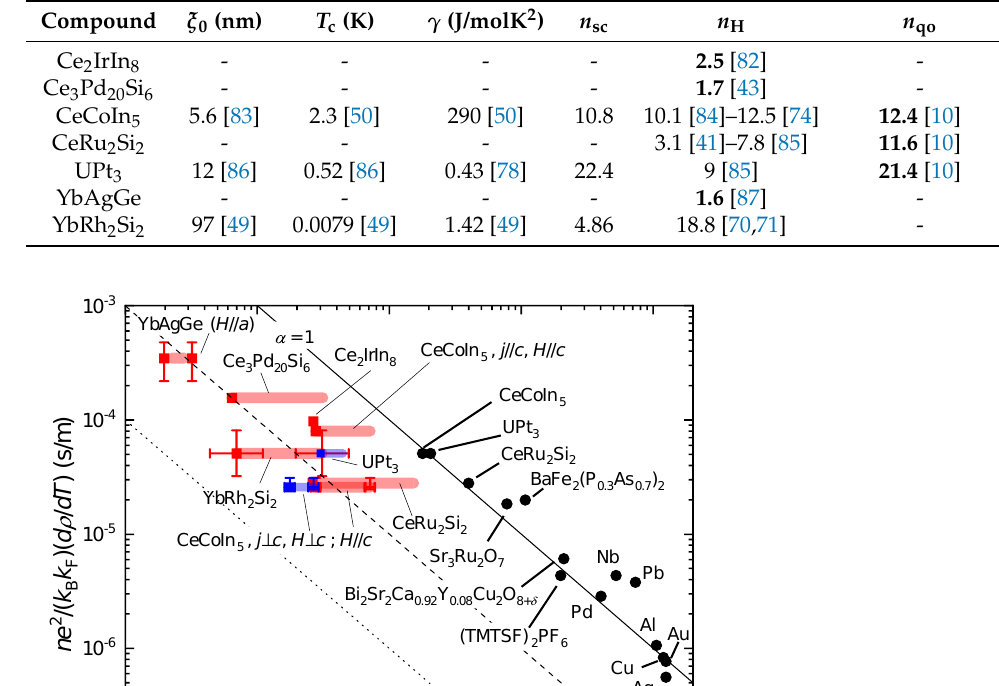
Table 2. Charge carrier concentrations (in nm − 3 ) determined as follows: (i) n sc from the supercon- ducting coherence length ξ 0 , the superconducting transition temperature T c , and the normal-state Sommerfeld coefficient γ , all in zero field, via (20); (ii) n H from the Hall coefficient at the lowest temperatures, where anomalous contributions are minimal, via R H = 1/ ne ; (iii) n qo from quantum oscillation experiments reviewed in [10], by summing up the carrier concentrations from all detected bands. For CeCoIn 5 , the γ coefficient is taken at 2.5 K, without taking into account the logarithmic divergence. The error bar in n used for CeCoIn 5 ( j ⊥ c ) in Figure 3 reflects the range of the parameters given in [74]. YbRh 2 Si 2 is close to being a compensated metal, resulting in a strong sensitivity of n to small differences in the residual resistivity. The largest reported R H value, which corresponds to n H = 26.0 [71], has the lowest compensation and is thus most accurate. Nevertheless, the R H value of LuRh 2 Si 2 is even larger, corresponding to n H = 11.6nm − 3 [70], suggesting that there is still some degree of compensation in the sample of [71]. We list the average of both values, 18.8nm − 3 , as best n H estimate. For the plots, we use the approximate average of n sc and n H , i.e., 10nm − 3 , with an effects are also encountered in UPt 3 [81]. Bold fonts indicate the values used for the α estimates (see Table1).